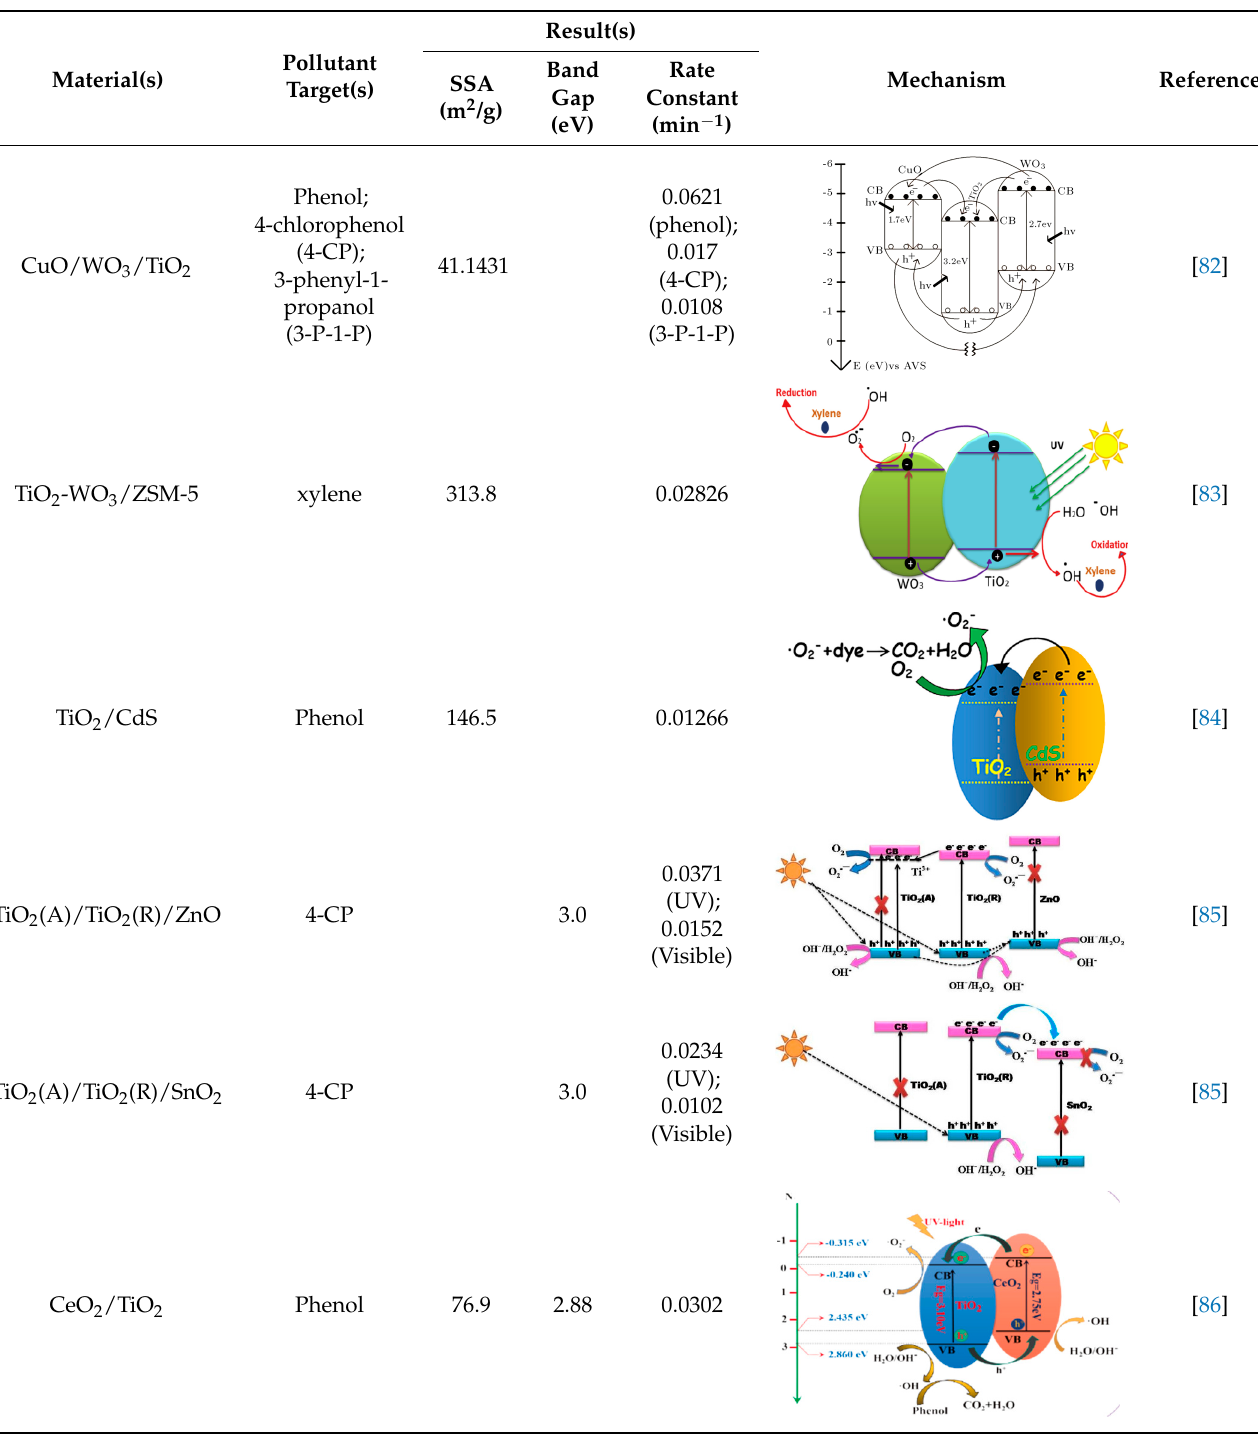
Figure 8. ( a ) Charge carrier migration mechanism of TiO 2 -based nanocomposite material, including trapping on TiO 2 and the second phase/component and ( b ) TiO 2 intercalation on the support mate- rial (example: graphene), which increases the light absorption region and intensity, charge carrier life-time, and absorptivity toward organic pollutants [81]. Table 4. TiO 2 -based heterojunction photocatalysts for organic pollutant treatment. Several images in the table are reproduced with permission from Elsevier, 2022.